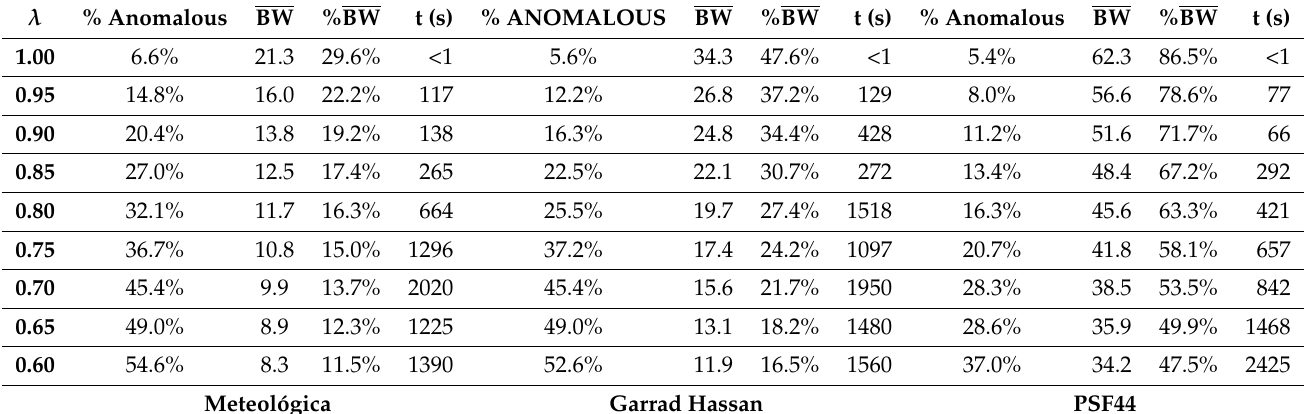
Table 2. Experimentally estimated attributes for confidence θ = 0.035 bands as λ